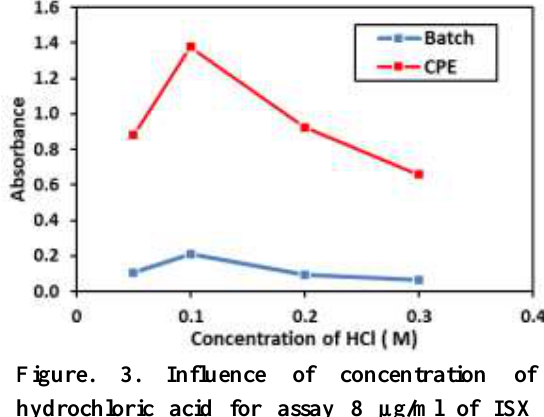
Figure. 3. Influence of concentration of